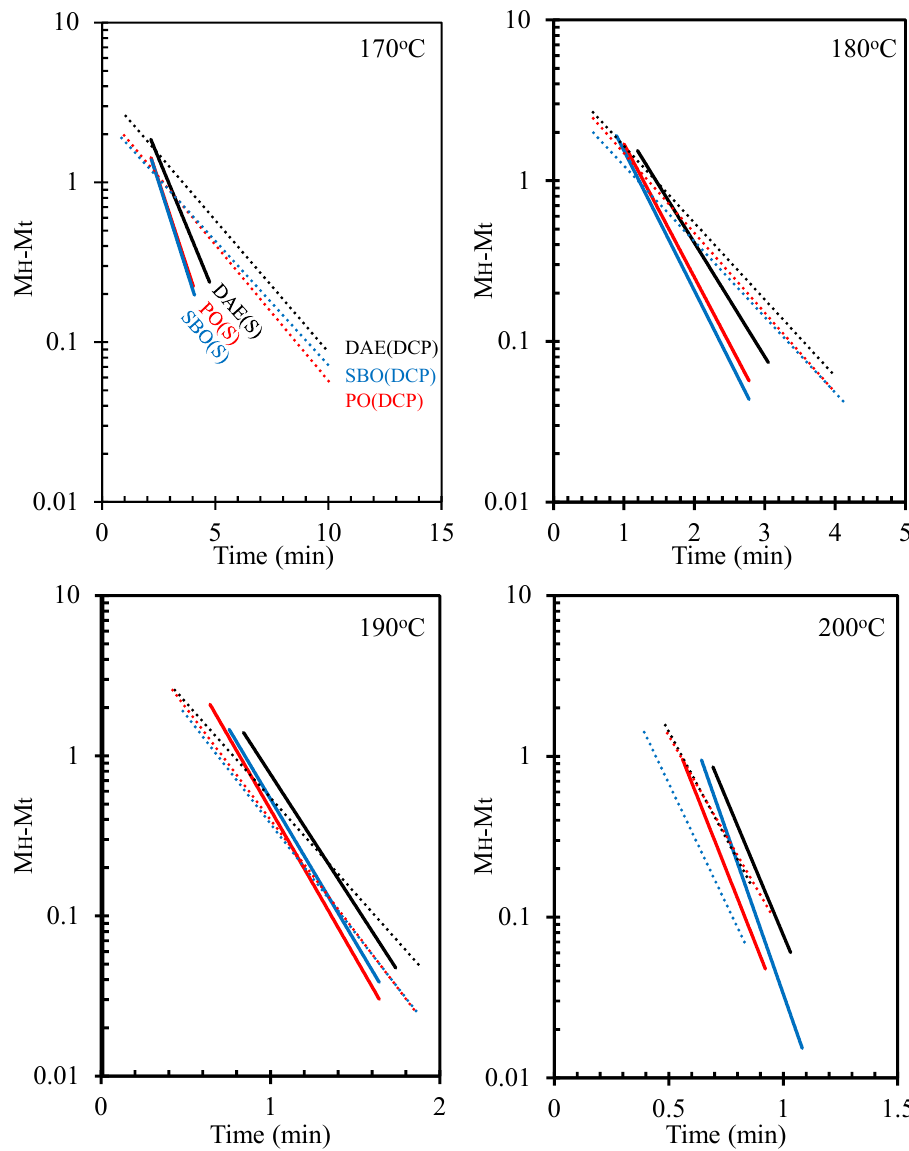
Figure 6. ln (M H − M t ) versus time (t) of NR compounds containing different types of oils under various curing systems.